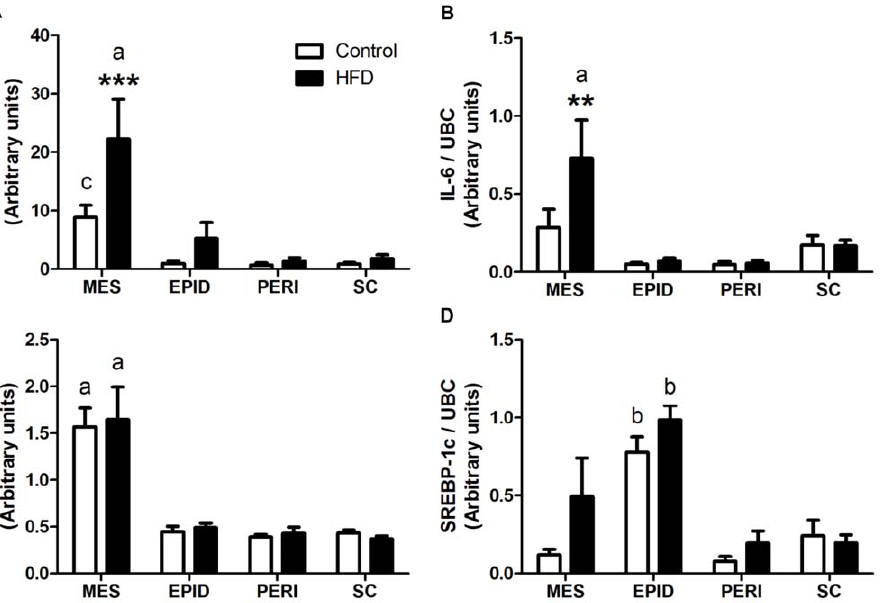
Figure 7. mRNA expression of TNF- a (A), IL-6 (B), PPAR- c (C) and SREBP-1c (D) in adipose tissue. mRNA levels in control and high saturated fat diet (HFD) fed mice were measured by RT-qPCR. Gene expression was normalized to UBC. Open bars=control; Closed bars=HFD (n=12–15 per group). Data are shown as mean 6 SEM. *** P , 0.001 and ** P , 0.01 compared to control. a, b, c: P , 0.001, P , 0.01 and P , 0.05 respectively compared to other depots in the same diet group.